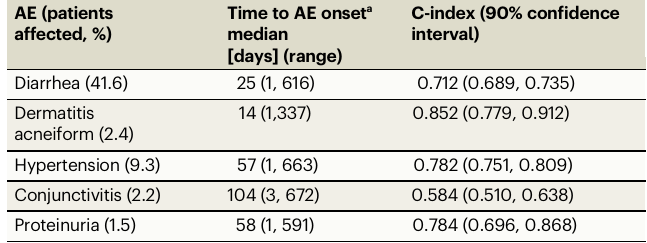
Table 1 | Predictive performances of the machine learning model on patient population data assessed by C-index AE (patients affected,